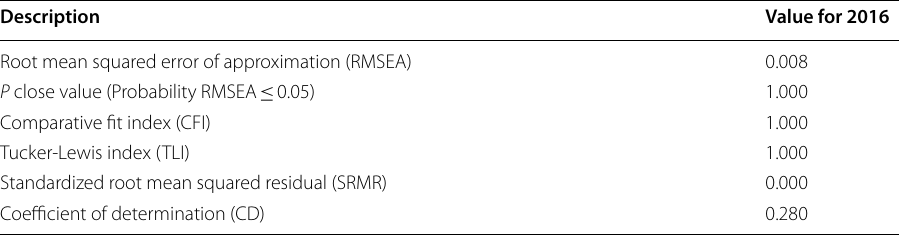
Table 6 SEM analysis on communication and innovation association with performance Manifest variables (for communication and